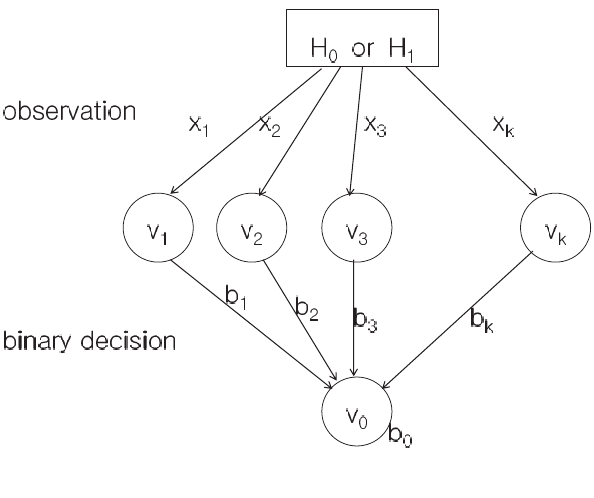
Figure 2. Distributed event